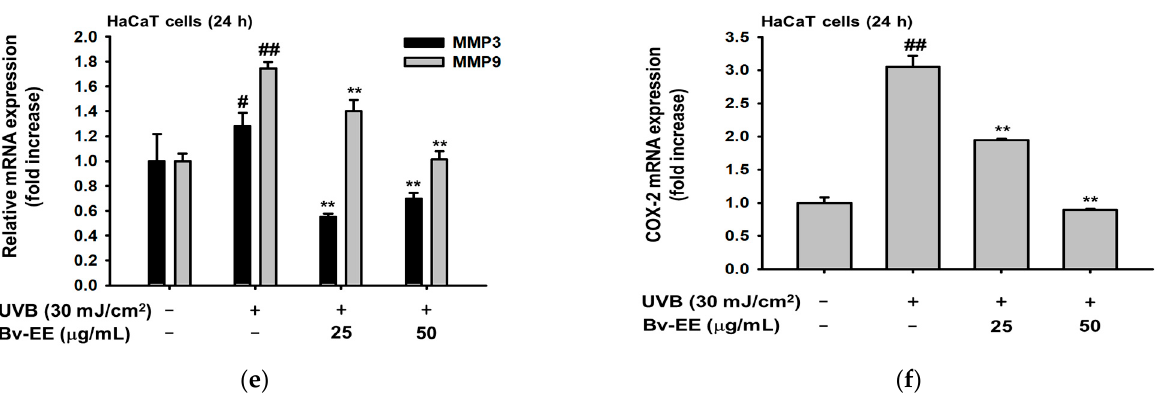
Figure 4. Bv-EE inhibits AP-1 promoter activity and mRNA expression of aging factors. ( a ) HEK293T cells were treated with different concentrations of Bv-EE for 24 h, and viability was measured using the MTT assay. ( b ) HEK293T cells transfected with AP-1-Luc, TRIF, β -galactosidase (control), and PEI were incubated for 24 h and examined by luminometer. ( c – f ) Real time PCR analyses of the expression of MMP3, MMP9, and COX-2 in HaCaT cells pretreated with Bv-EE and then subjected to H 2 O 2 (200 μ M) or UVB (30 mJ/cm 2 ) for 24 h. The fold increase represents the ratio between the increase in mRNA expression in the Bv-EE treated groups and that in the normal group. GAPDH was used as an internal control. All results are expressed as means ± standard deviations. # p < 0.05, ## p < 0.01 compared with the positive control group, and * p < 0.05, ** p < 0.01 compared with the normal group.